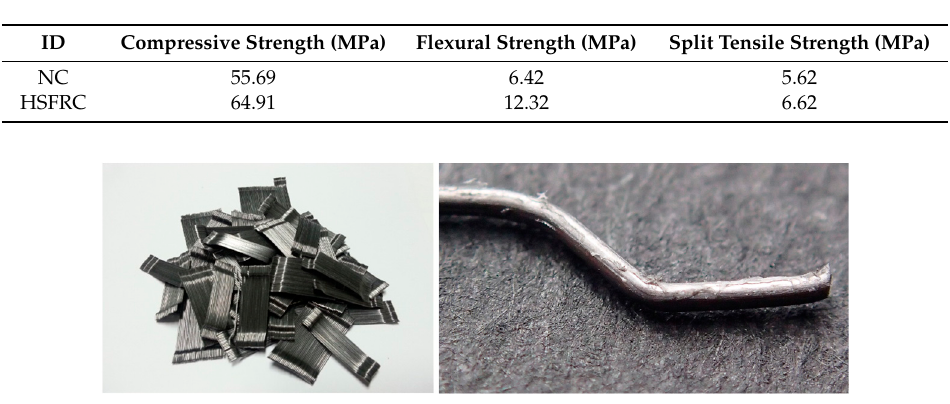
Figure 4. Shape of the hooked steel fiber.